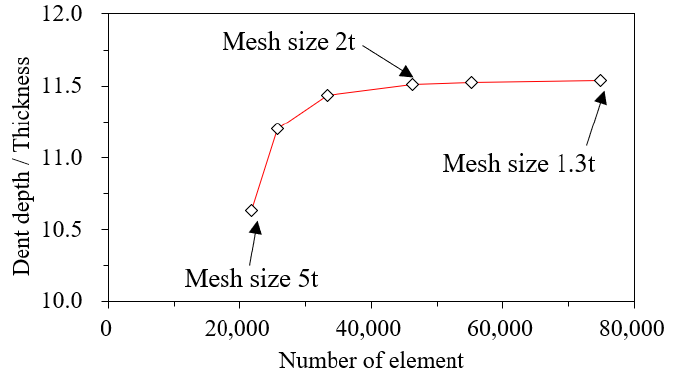
Figure 19. Results of the mesh convergence tests with tendency line.